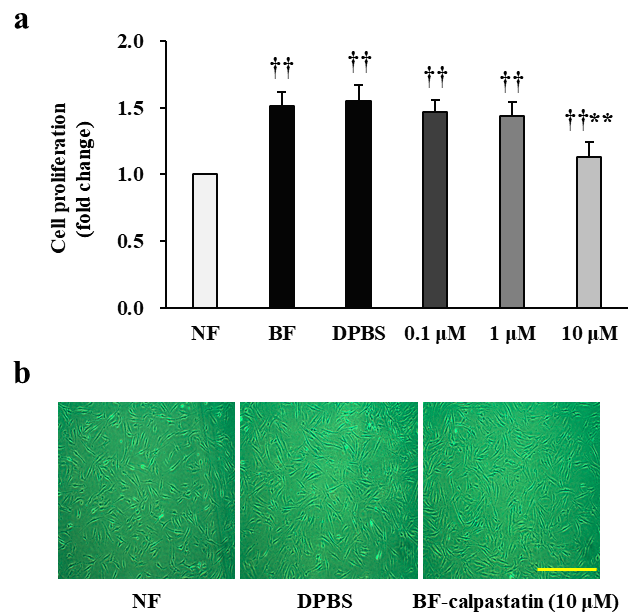
Figure 3. Effect of calpastatin on the proliferation of fibroblasts obtained from patients with burn injuries. ( a ) Proliferation observed in normal fibroblasts (NF), burn-wound fibroblasts (BF), Dulbecco’s phosphate-buffered saline (DPBS)-treated BFs (DPBS), and BFs treated with calpastatin at different concentrations (0.1, 1, and 10 μ M) for 48 h. ( b ) Cell images (10×) showing NFs, DPBS-treated BFs, and calpastatin (10 μ M)-treated BFs. Scale bar = 50 μ m. Proliferation of BFs upon calpastatin treatment was compared with and normalized to that of NFs or DPBS-treated BFs for each patient. †† p < 0.01 vs. NFs; ** p < 0.01 vs. DPBS-treated BFs. Data are expressed as mean ± standard error of the mean, n = 34 (each group).